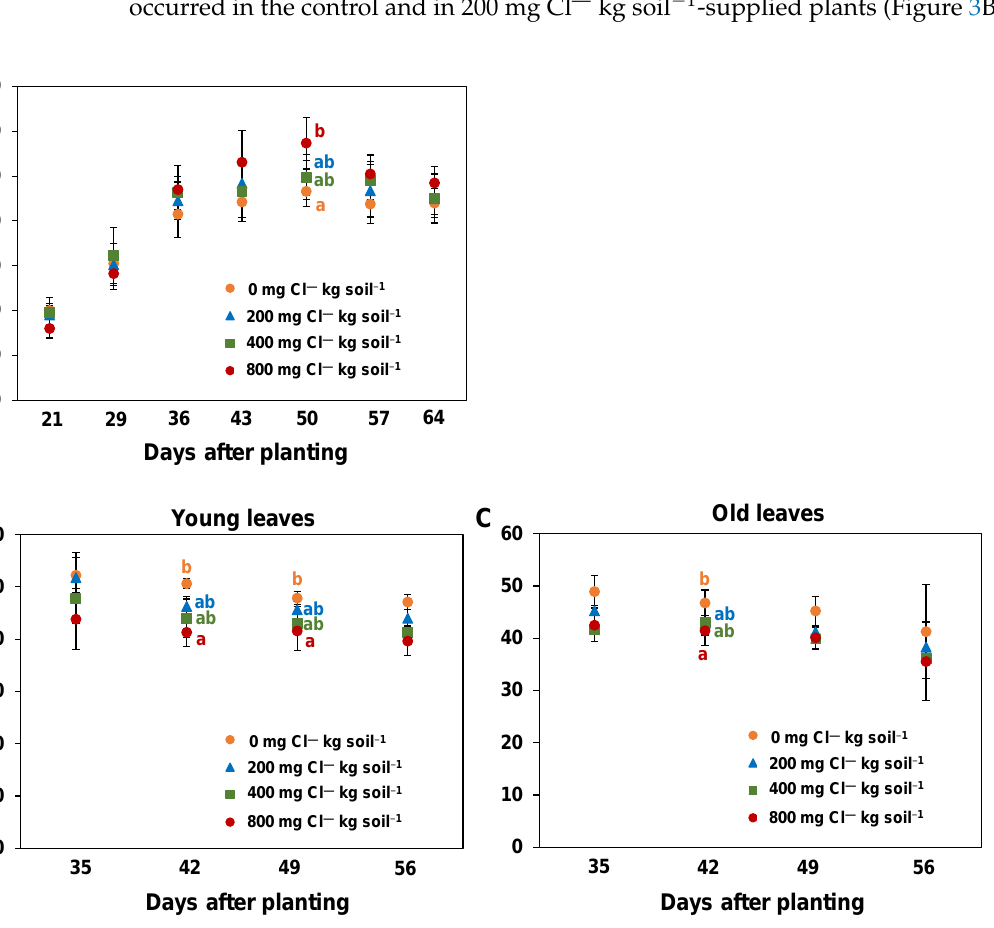
Figure 4. The effect of increasing chloride (Cl ― )-fertilization on tuber yield, tuber dry matter and tuber number. Tuber yield ( A ), tuber dry matter ( B ), and tuber number at harvest ( C ) (87 days after planting). Plants were treated with four Cl ― supplies: 0 mg Cl ― kg soil −1 (control plants); 200 mg Cl ― kg soil −1 ; 400 mg Cl ― kg soil −1 ; 800 mg Cl ― kg soil −1 . Mean ± SE values; n = 4. No indica- tion means there was no significant effect. 4. Discussion